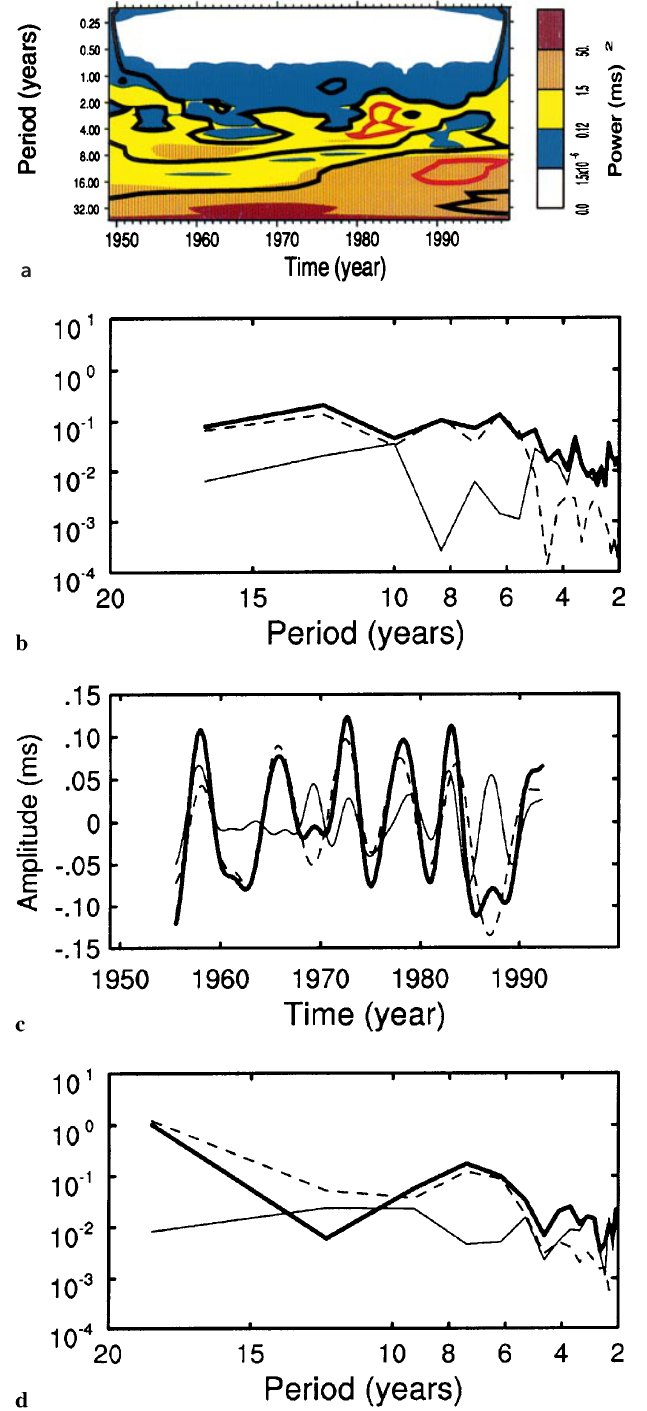
Fig. 2. a Wavelet power spectrum of the LOD time series. The contour levels are chosen so that 75%, 50%, 25% and 5% of the wavelet power is above each level, respectively. Black and red contours are the 50% and 90% significance level, using the global wavelet spectrum as the background. b Power spectral density, in units of ms 2 /year, of LOD ( solid bold line ), AAM ( light solid line ), and the di(cid:128)erence, LOD-AAM ( dashed line ), for the period 1949–1998, for interannual periods longer than 2 years. c Band-passed (between 5 and 8 years) series for LOD ( solid bold curves ), AAM ( light solid curves ) and the di(cid:128)erence LOD-AAM ( dashed curve ). d Same as b , but restricted to data between 1949 and